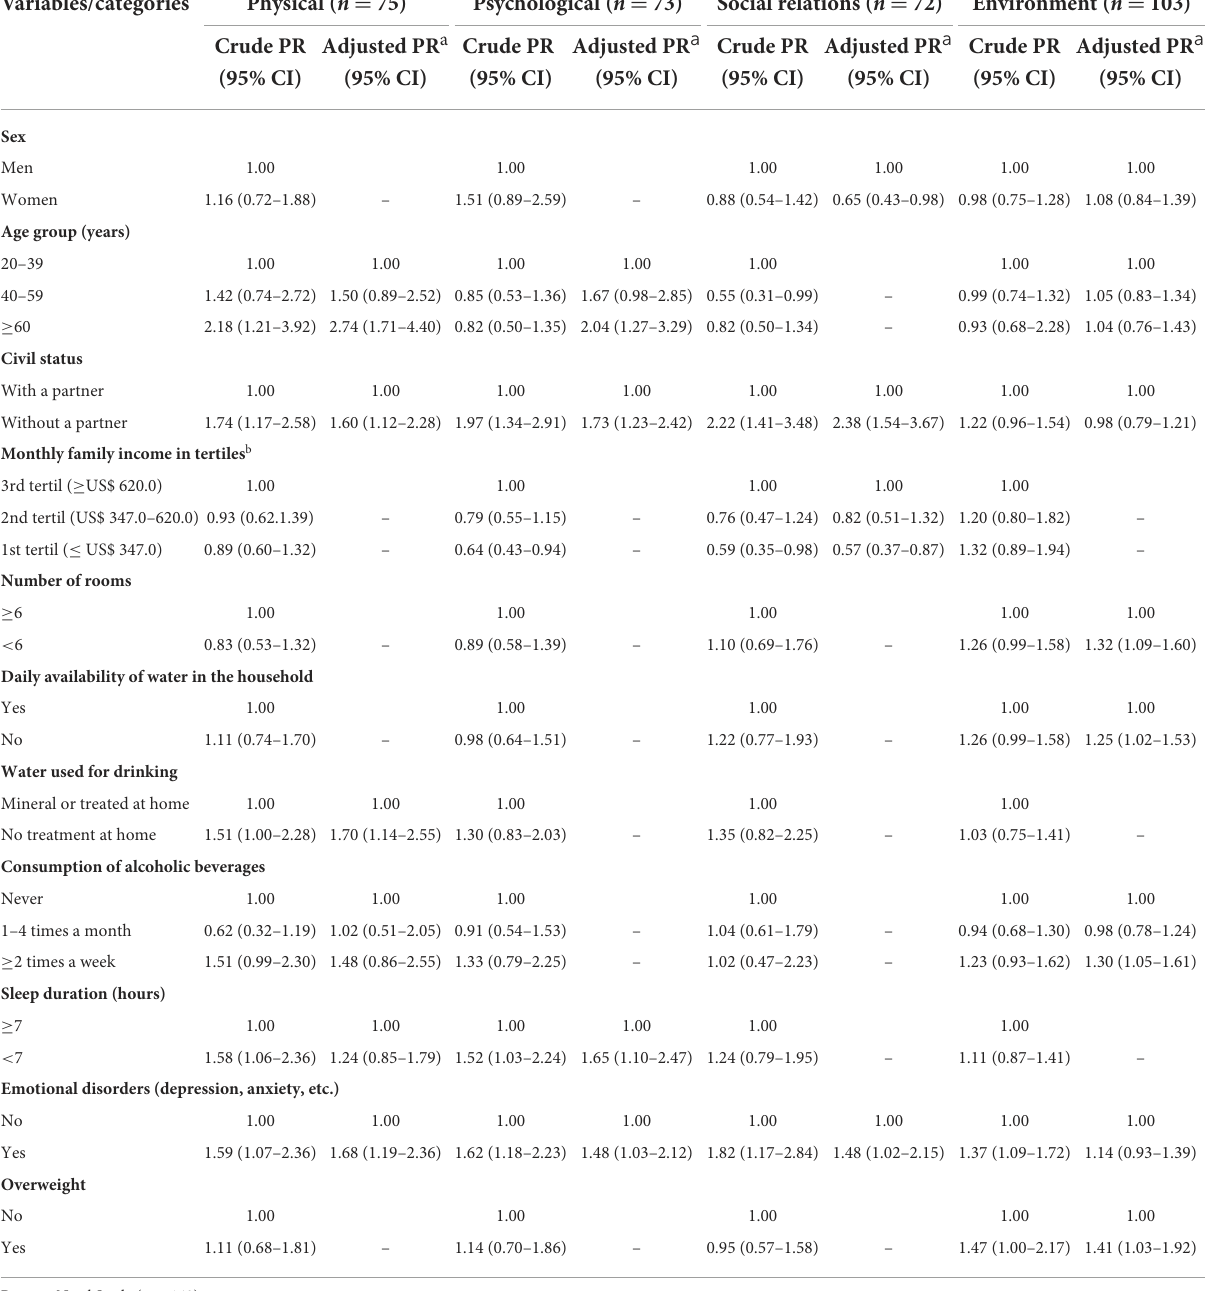
TABLE 3 Crude and adjusted Prevalence Ratios (PR) and Confidence Intervals (95%) of the variables associated with low perceived quality of life (LPQoL) in the physical, psychological, social relations and environment domains of adults and older adults with Food Insecurity (FI).